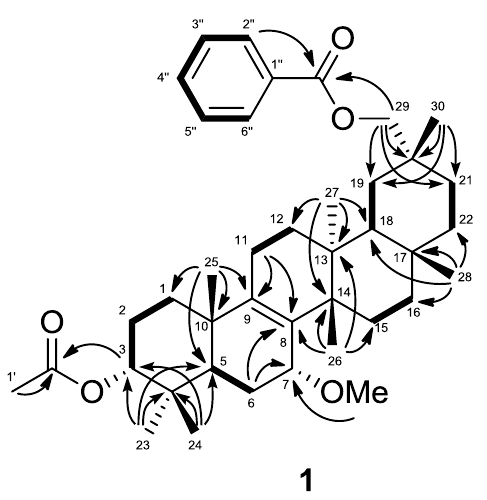
Figure 2. Key HMBC ( ) and 1 H- 1 H COSY ( ) correlations of 1 .